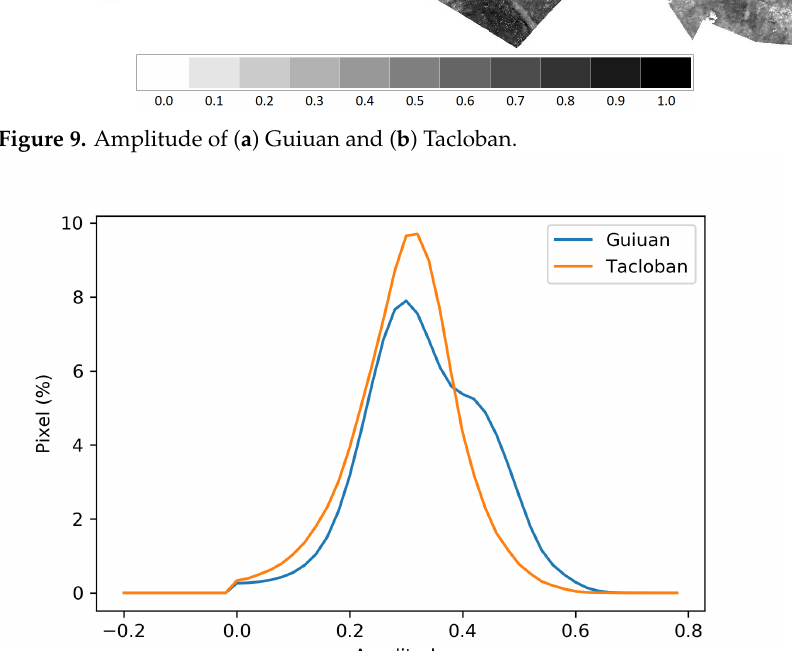
Figure 10. Amplitude histogram of the Guiuan and Tacloban